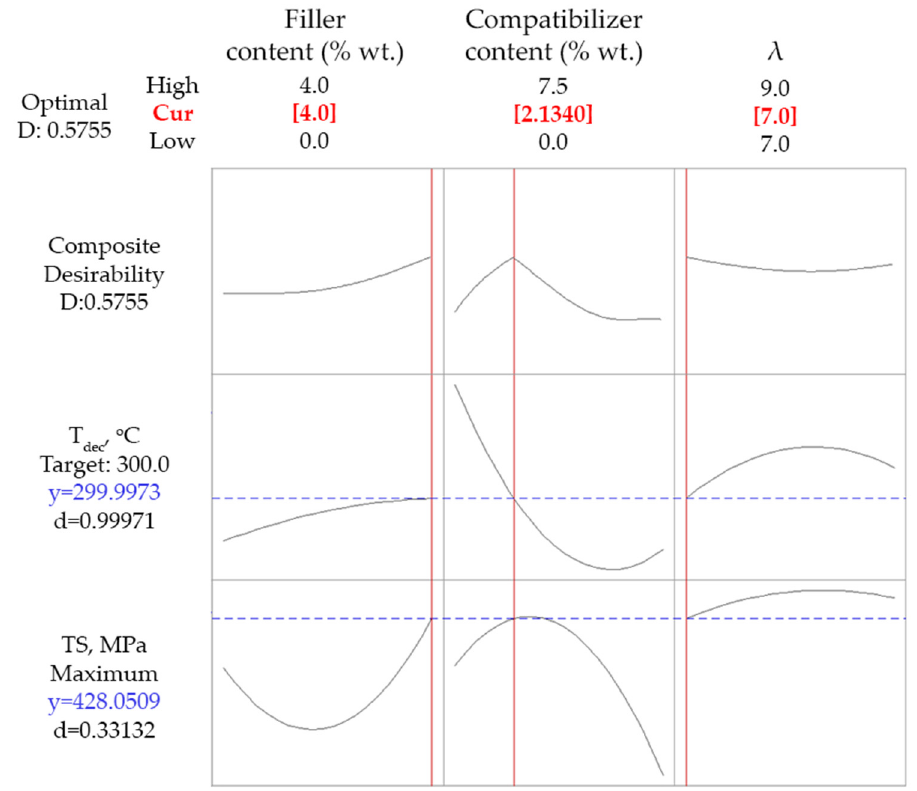
Figure 6. Constrained optimization results for composites with talc, imposing a drawing ratio of 7 and targeting maximization of TS and T dec at least equal to 300 ◦ and targeting maximization of TS and T dec at least equal to 300 °C.